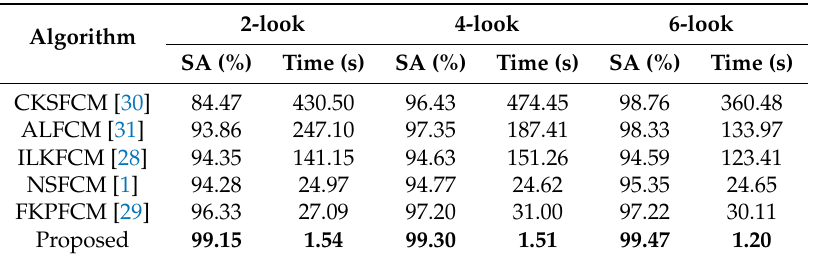
Table 2. Experimental results on SI2 simulated